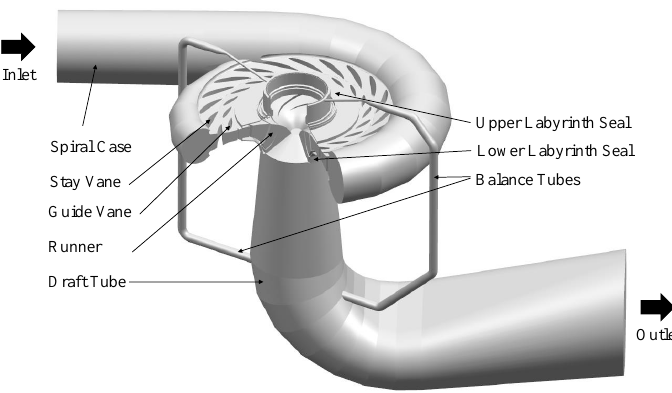
Figure 4. The 3D modeling of flow passage of the unit.